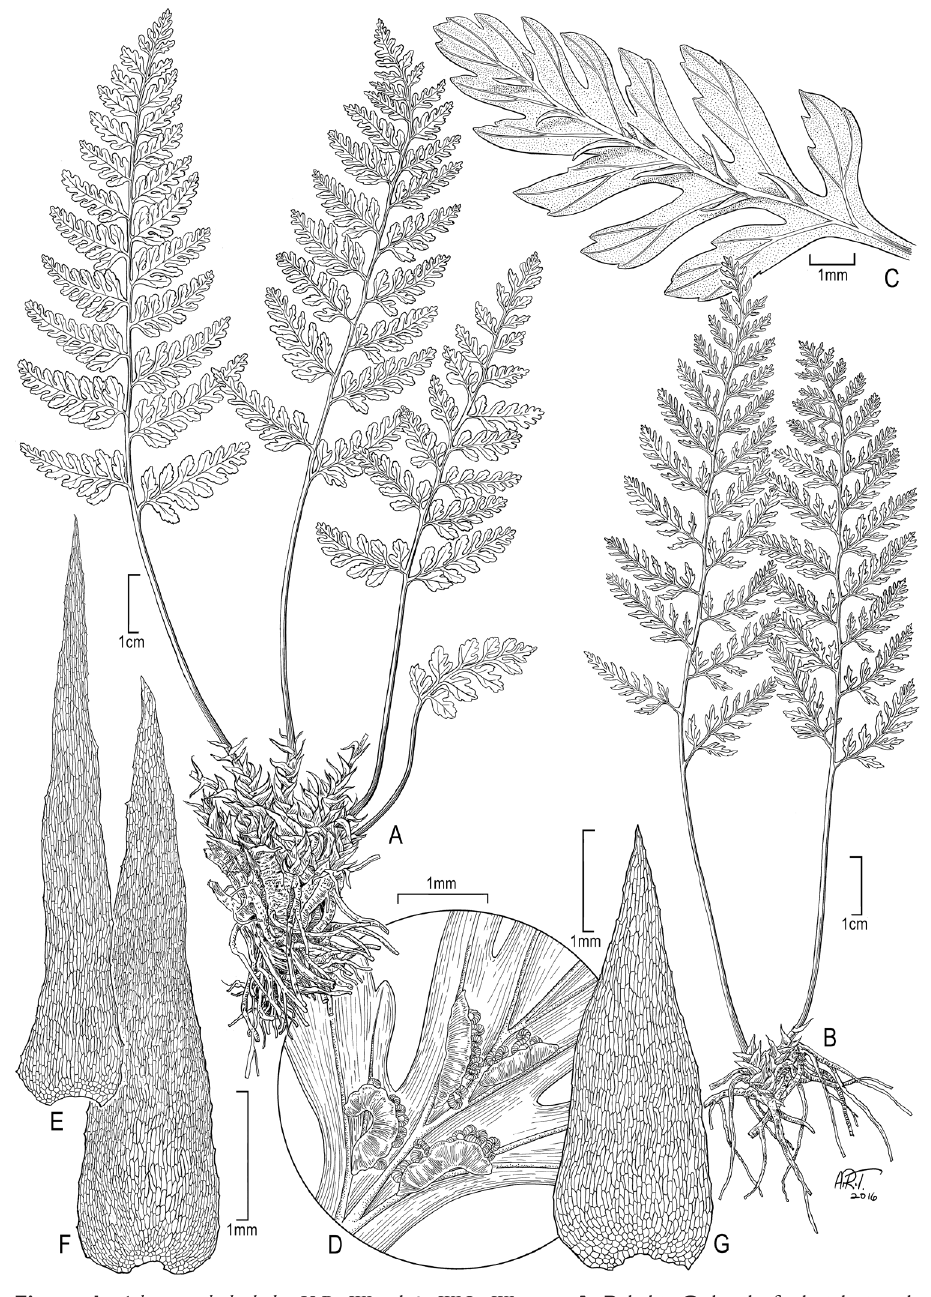
Figure 1. Athyrium haleakalae K.R. Wood & W.L. Wagner. A–B habit C detail of adaxial pinnule showing venation and fleshy spines D detail of abaxial pinnule showing range of sori shapes E–F lower stipe scales G rhizome scale. A–G from Perlman et al. 23964 (BISH, PTBG, UC, US) (Illustration by Alice